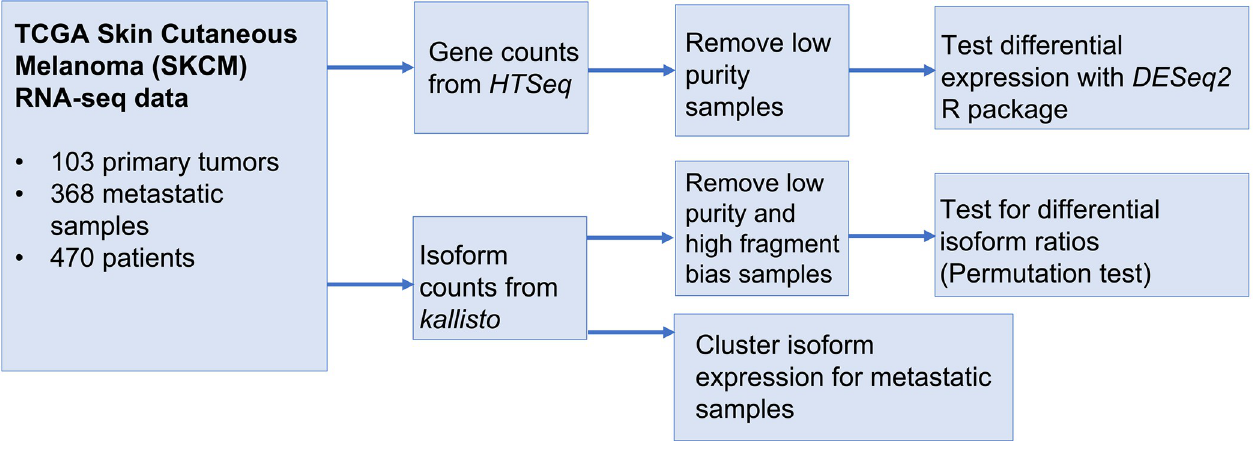
Fig 1. Data analysis